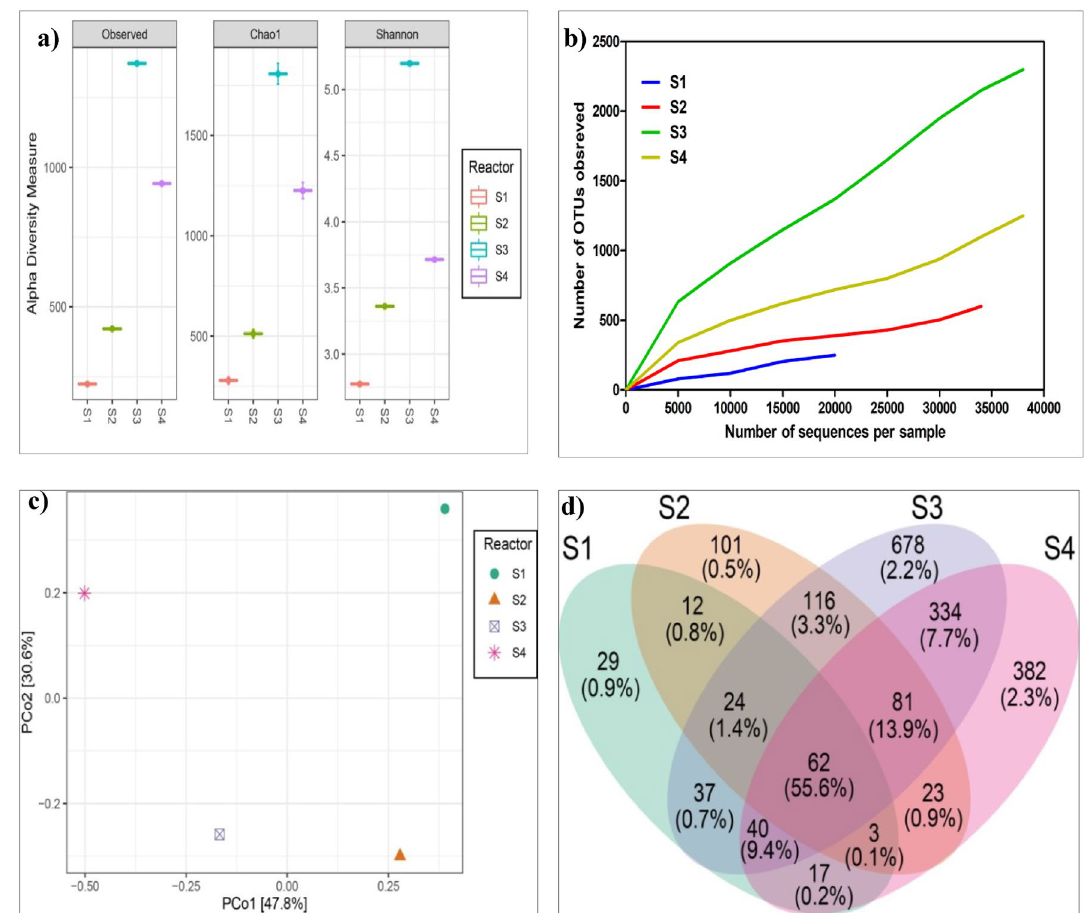
Figure 4. ( a ) Observed OTUs, Chao, and Shannon of anodic biofilm that developed over different anode surfaces. ( b ) Rarefaction curves of anodic biofilm formed over other fabricated anodes (S1–S4). ( c ) PCo plot shows the relationship among the biofilm communities. ( d ) Venn diagram of shared and uniquely identified the OTU of electroactive biofilm enriched with different energy substrates. The OTUs were defined at 0.03